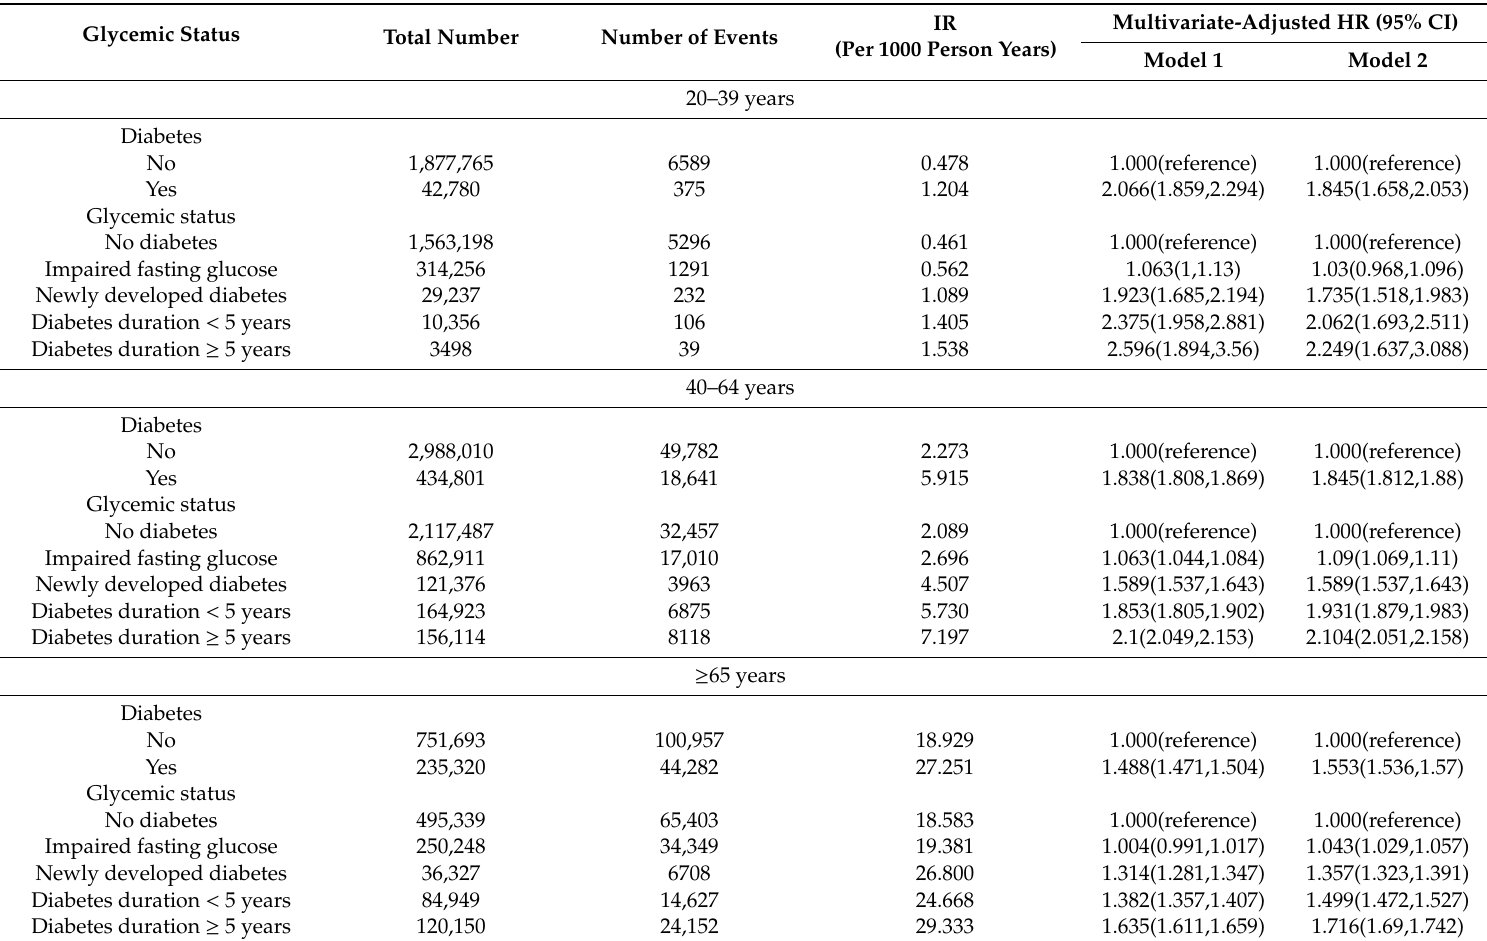
Table 4. IR and multivariate-adjusted HR of mortality according to baseline glycemic status in di ff erent age